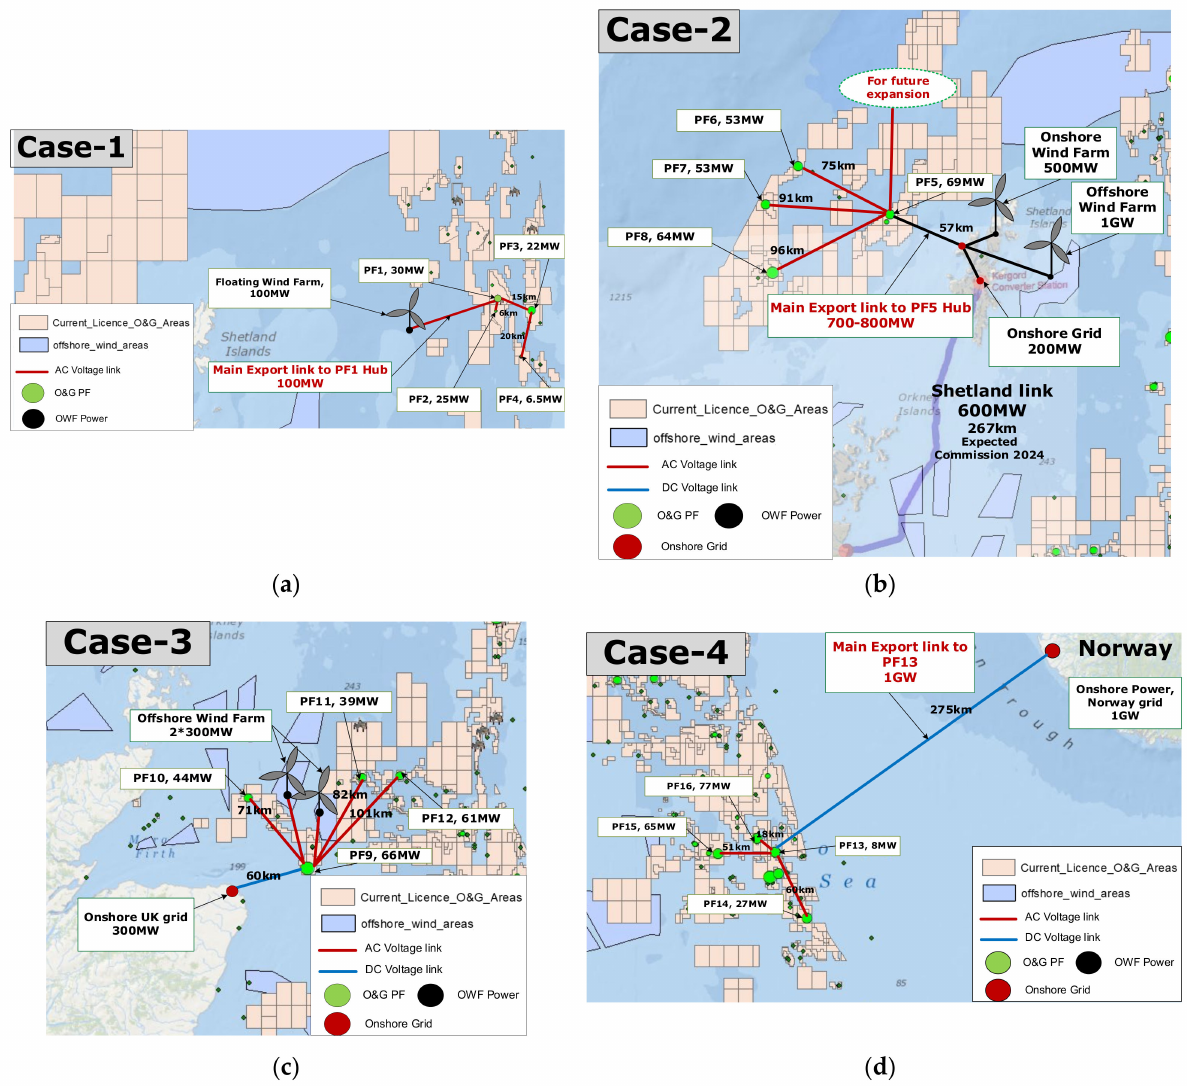
Figure 1. Four hypothetical case studies: ( a ) Case-1, ( b ) Case-2, ( c ) Case-3 and ( d )